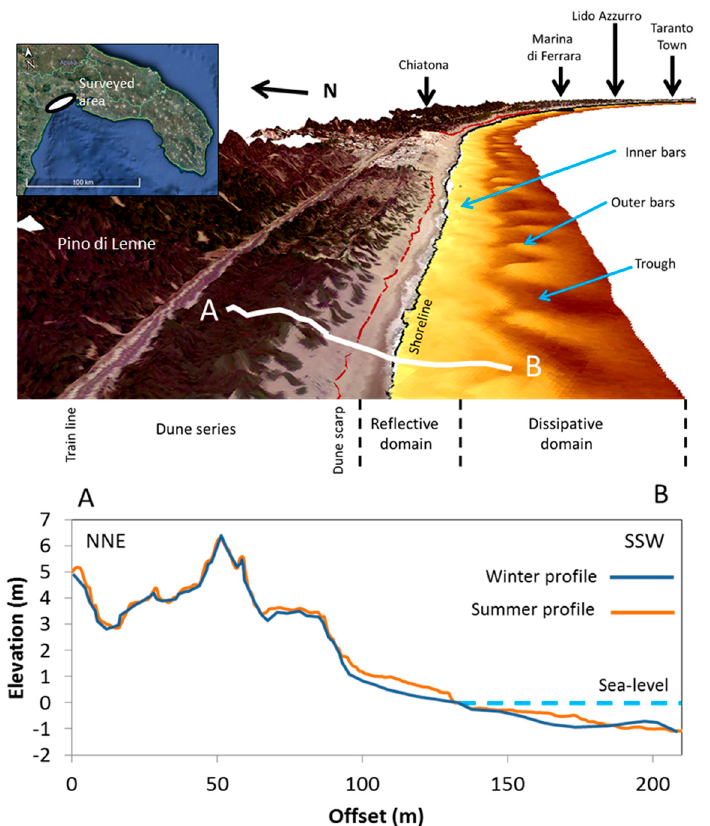
Figure 6. Morpho-topographic and morpho-bathymetric digital models obtained by direct surveys performed on the sandy coast stretching from the Castellaneta beach to the City of Taranto.